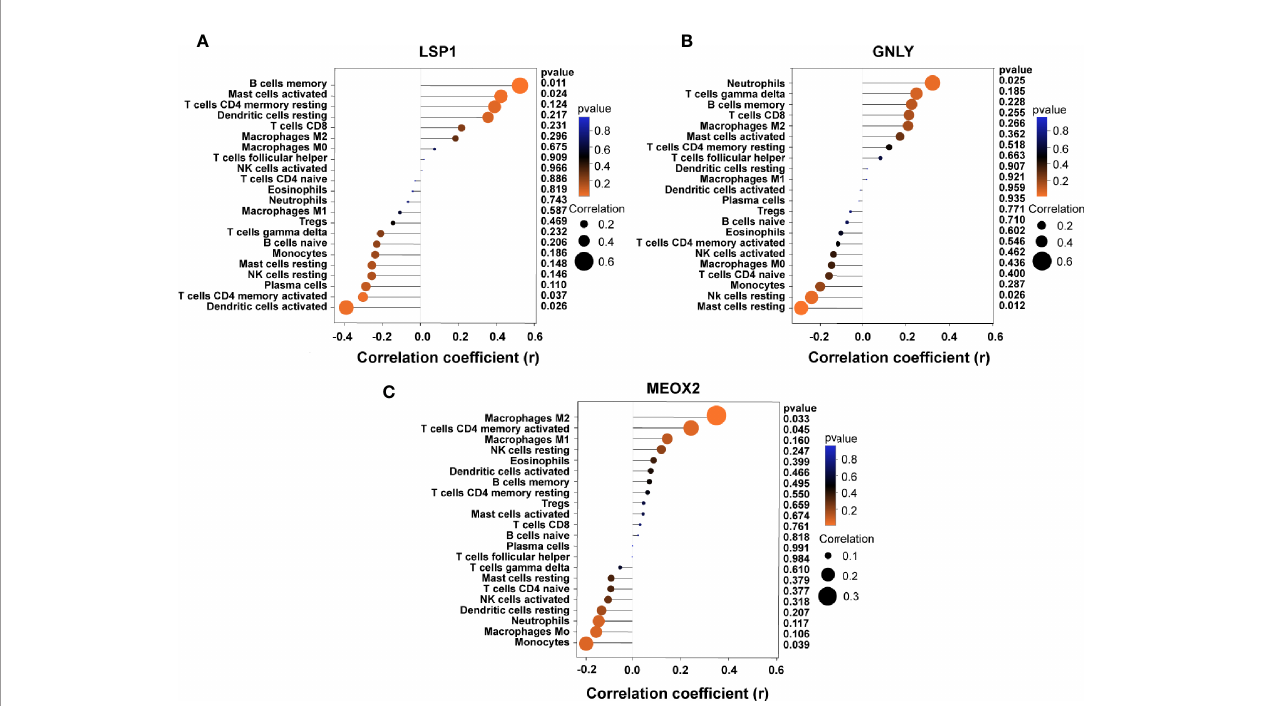
FIGURE 8 | Correlation between diagnostic markers and in fi ltrating immune cells. (A) Correlation between LSP1 and in fi ltrating immune cells. (B) Correlation between GNLY and in fi ltrating immune cells. (C) Correlation between MEOX2 and in fi ltrating immune cells. The size of the dots represents the strength of the correlation between genes and immune cells; the larger the dots, the stronger the correlation, and the smaller the dots, the weaker the correlation. The color of the dots represents the p -value; the greener the color, the lower the p -value; and the red the color, the larger the p -value. P < 0.05 was considered statistically signi fi